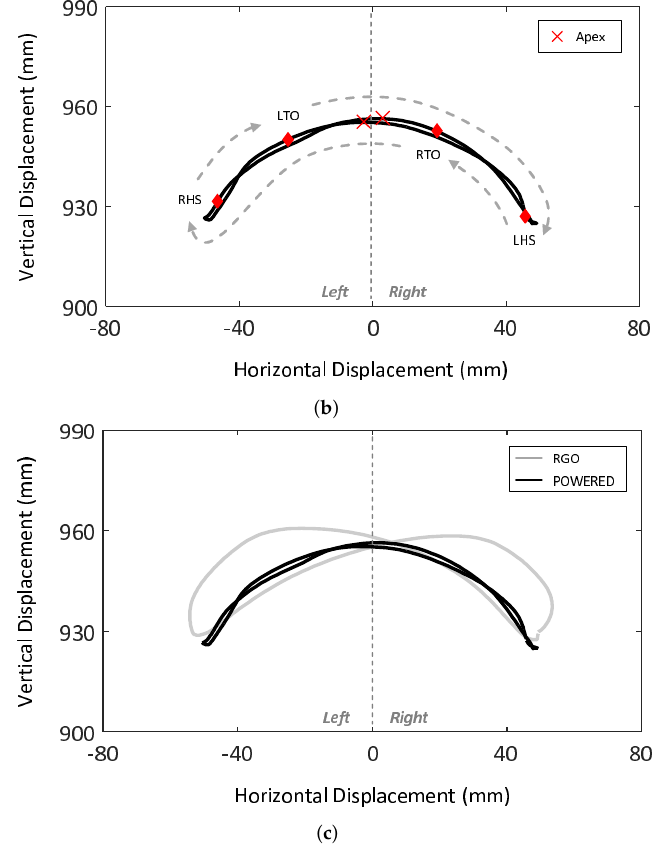
Figure 10. Center of mass trajectory in the frontal plane under the RGO condition ( a ) and the POWERED condition ( b ). Their trajectories are overlapped for comparison in ( c